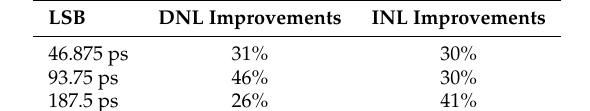
Table 3. Linearity improvements for the proposed DDL-TDC and TDL-TDC.